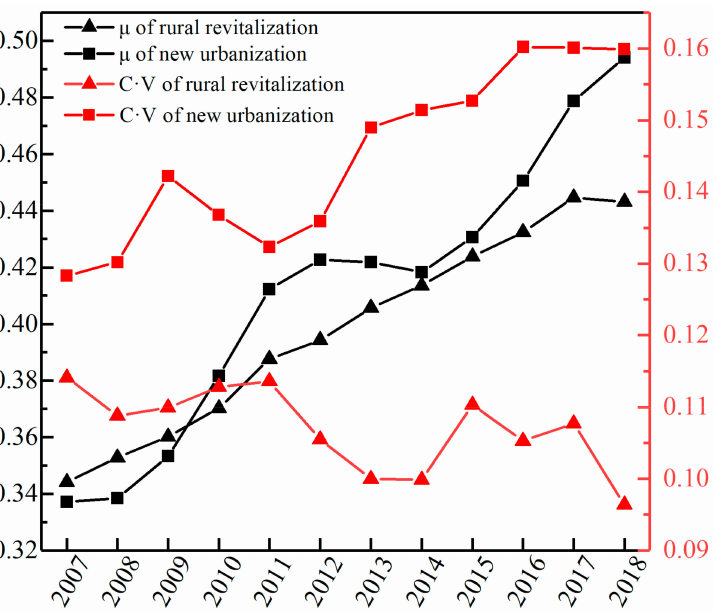
Figure 3. Characteristic maps of R (a) and U (b) in China during 2007–2018. (Source: made by authors). The relationship between R (a) and U (b) , R (a) was above U (b) during 2007–2009, but by 2010, U (b) overtook R (a) and stayed ahead for the rest of the year. During 2010–2014, the gap between R (a) and U (b) first increased, then decreased, and by 2014, the gap reached its smallest level during the study period. However, good times did not last long, and the gap between the two widened rapidly after 2014, reaching a peak in 2018. It can be seen that the new urbanization level had been in the leading position after it surpassed the rural revitalization level in 2009. And the gap between them showed a trend of increasing after